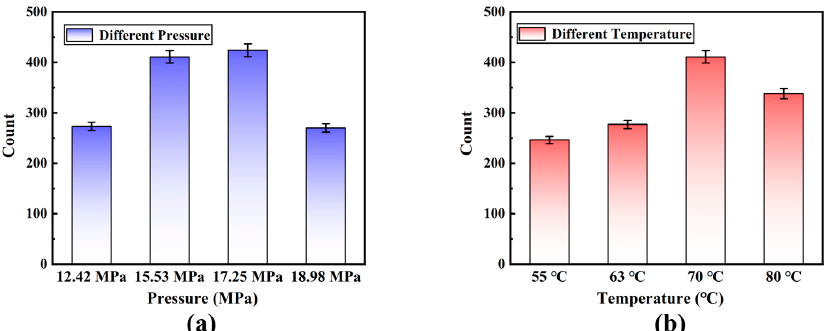
Figure 9. The number of pores counts during tensile fracture of polyurea under different conditions: ( a ) different spraying pressures under the 70 ◦ C; and ( b ) different spraying temperatures under the ( a ) different spraying pressures under the 70 °C; and ( b ) different spraying temperatures under the 17.25 17.25 MPa.